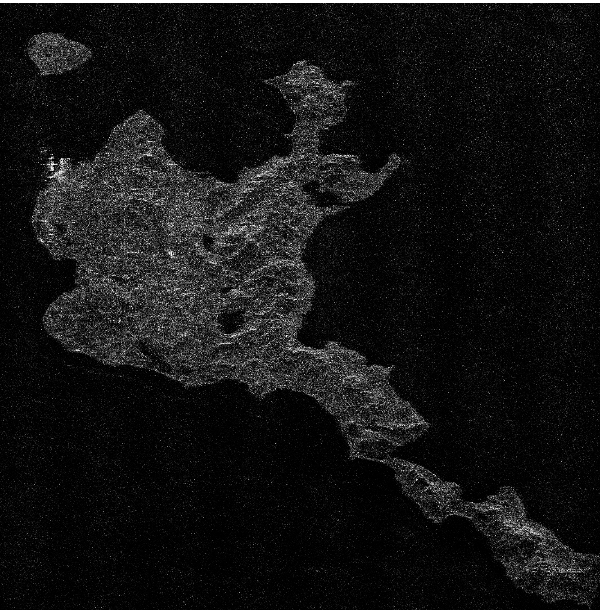
Figure 19. The result of the algorithm proposed in this paper when the Sentinel-1 radar azimuth is periodically missing data (vertical range, horizontal azimuth).